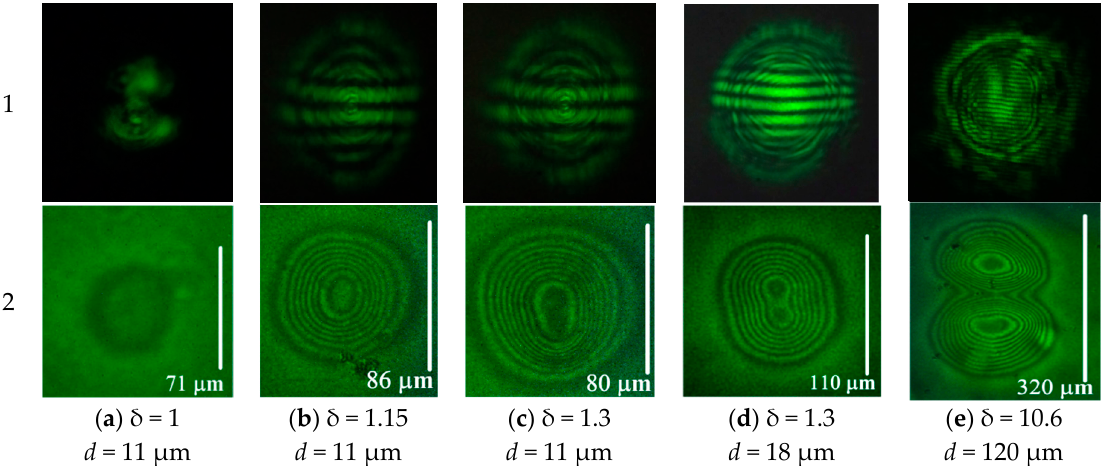
Figure 5. Steady-state aberrational patterns for the oblique ( α = 35 ◦ ) light incidence (row “1”) and corresponding microphotographs (row “2”) obtained for normalized beam power: at ( a – c ) focal plane ( d = 11 µ m), ( d ) 1-mm displacement from the focal plane ( d = 18 µ m), and ( e ) 5-mm displacement from the focal plane ( d = 120). The normalized power is δ = ( a ) 1, ( b ) 1.15, ( c , d ) 1.3, and ( e ) 10.6. Aberrational-pattern vertical angular size is ( a ) 0.1, ( b ) 0.34, ( c ) 0.37, ( d ) 0.36, and ( e ) 0.22 rad. Vertical white bar indicates the size of the recorded phase structure.